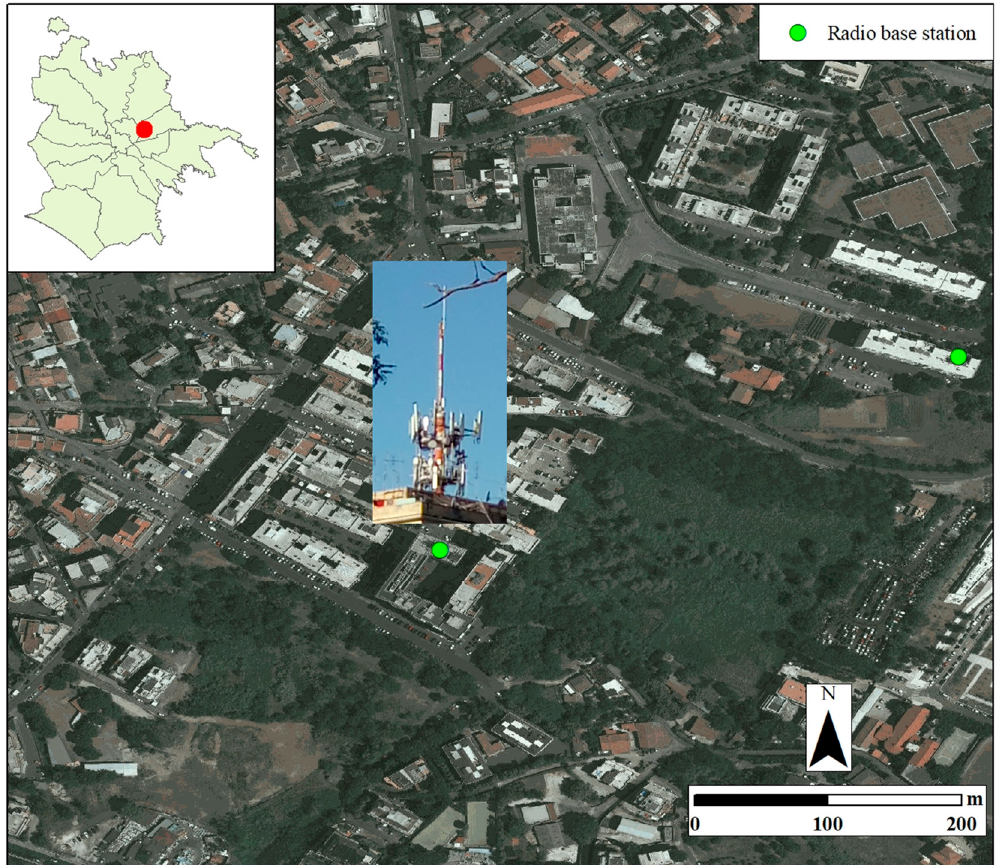
Figure 4. Geolocalization of an imposing high antenna in a sector of north-east Rome and its photo obtained during the field surveys. Source: authors’ elaboration.